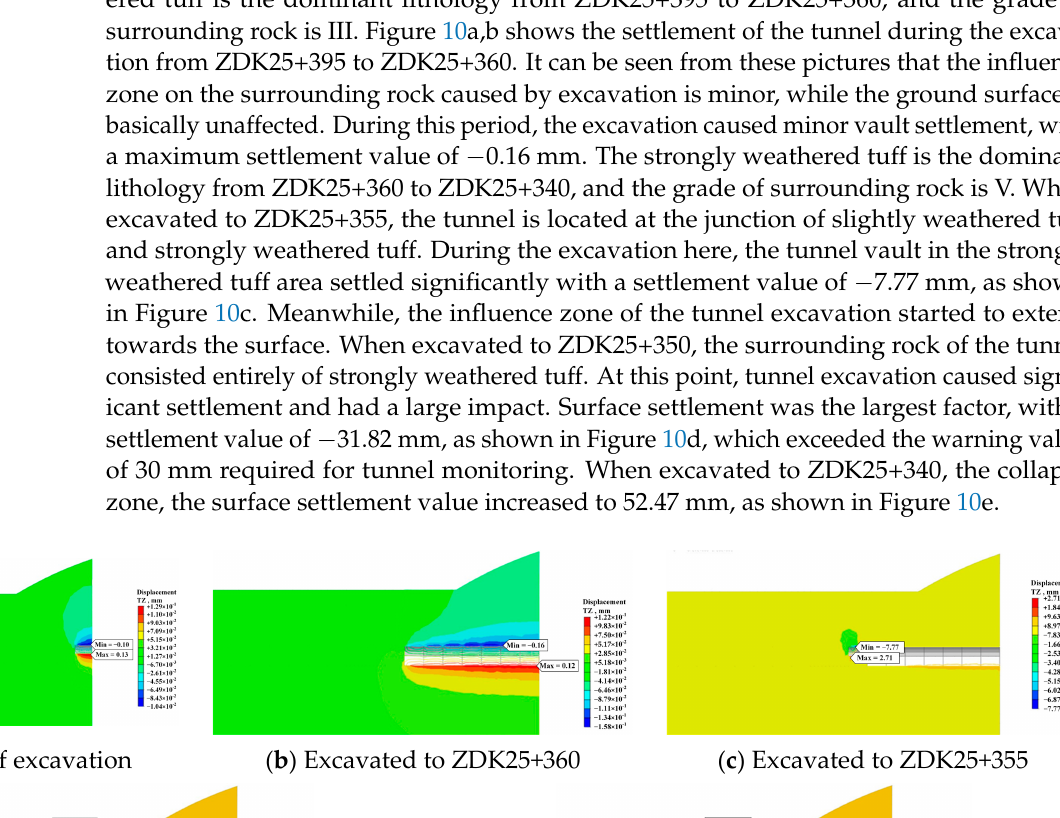
Figure 9. Numerical model of tunnel.